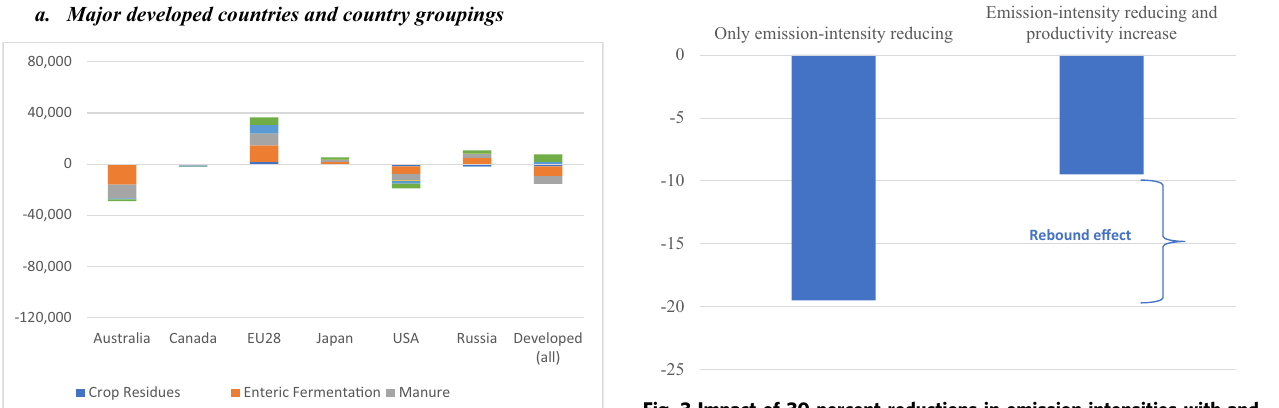
Fig. 3 Impact of 30 percent reductions in emission intensities with and without agricultural productivity increases (percentage change from baseline). The fi gure shows the impacts on global GHG emissions in two alterative scenarios. In the fi rst scenarios ( “ only emission reducing ” ) public support is redirected towards more R&D to achieve a 30% reduction in emission intensities and assuming new technologies become accessible at